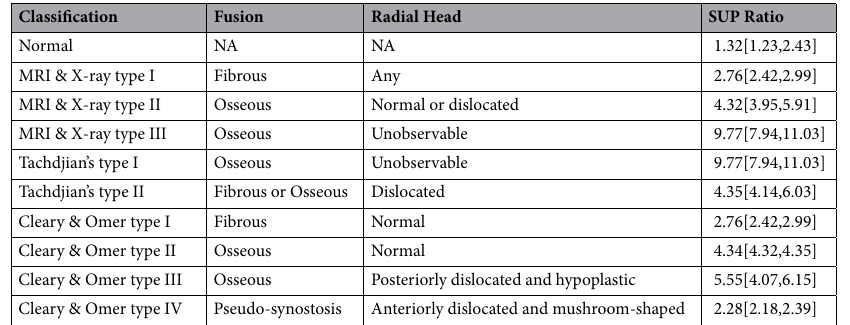
Table 3. Comparison between Tachdjian’s, Cleary & Omer, MRI & X-ray Based classification systems.